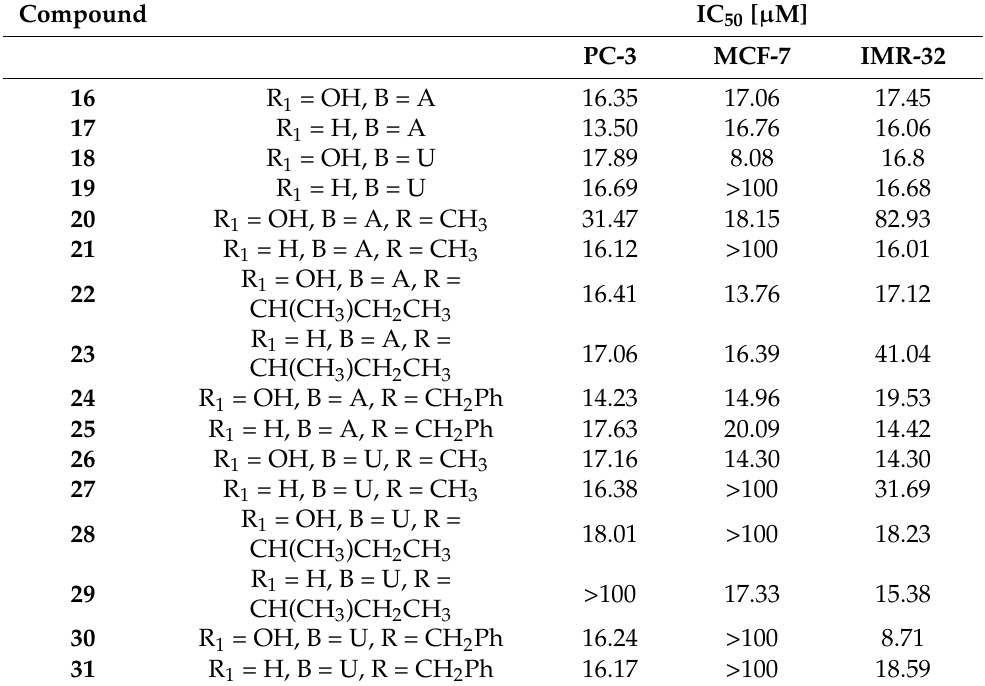
Table 2. In vitro anticancer activity evaluation of 16 – 31 by MTT